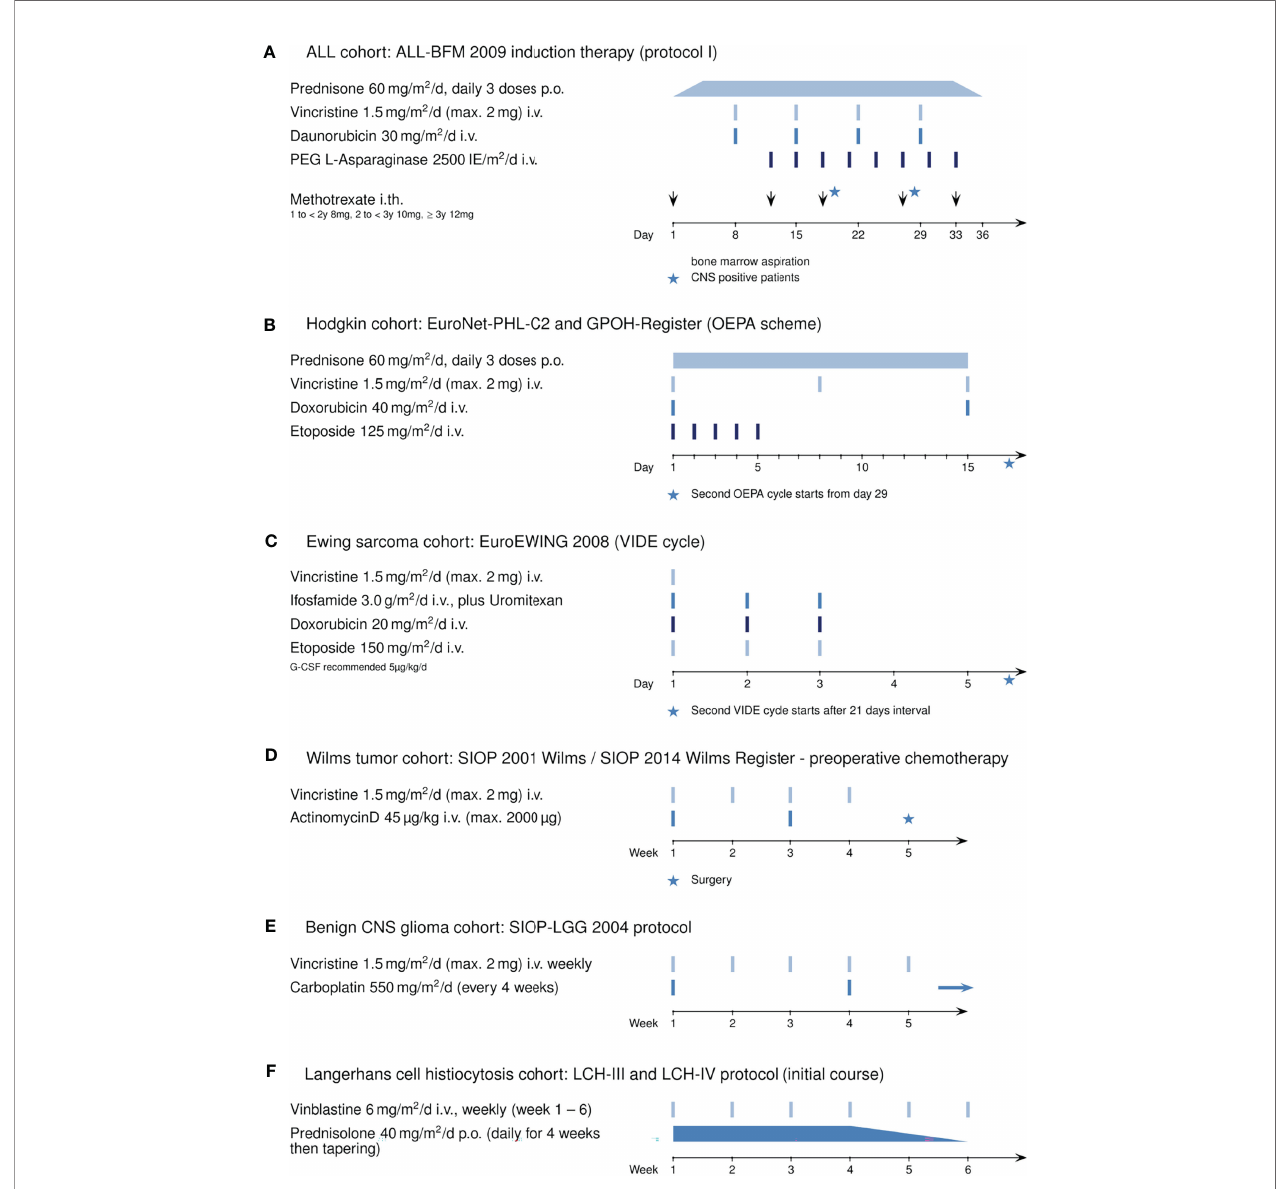
FIGURE 1 | Induction therapy protocols using vincristine or vinblastine: (A) ALL cohort: ALL-BFM 2009 (Protocol I, induction), (B) Hodgkin ’ s cohort: EuroNet-PHL- C2 protocol and GPOH Register (OEPA scheme), (C) Ewing sarcoma cohort: EuroEWING 2008 (VIDE cycle), (D) Wilms tumor cohort: SIOP 2001 Wilms and SIOP 2014 Wilms Register (preoperative chemotherapy), (E) benign CNS glioma cohort: SIOP-LGG 2004, and (F) Langerhans cell histiocytosis cohort: LCH-III and LCH-IV